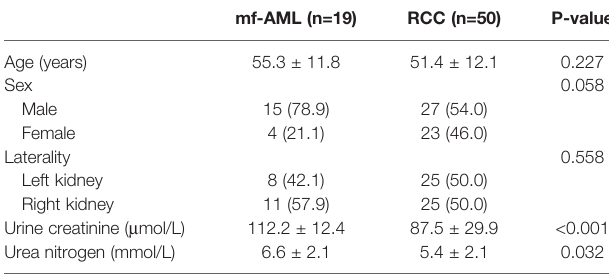
TABLE 1 | Characteristics of patients and tumors.